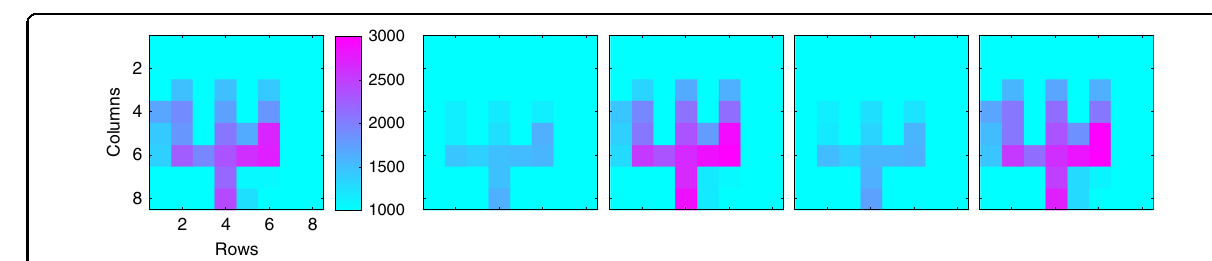
Fig. 6 Image and interference observed simultaneously. Images for fi ve different phase-instances are shown along with the coherent variation of intensity across the illuminated pixel. The visibilities varied in the range 0.85 −